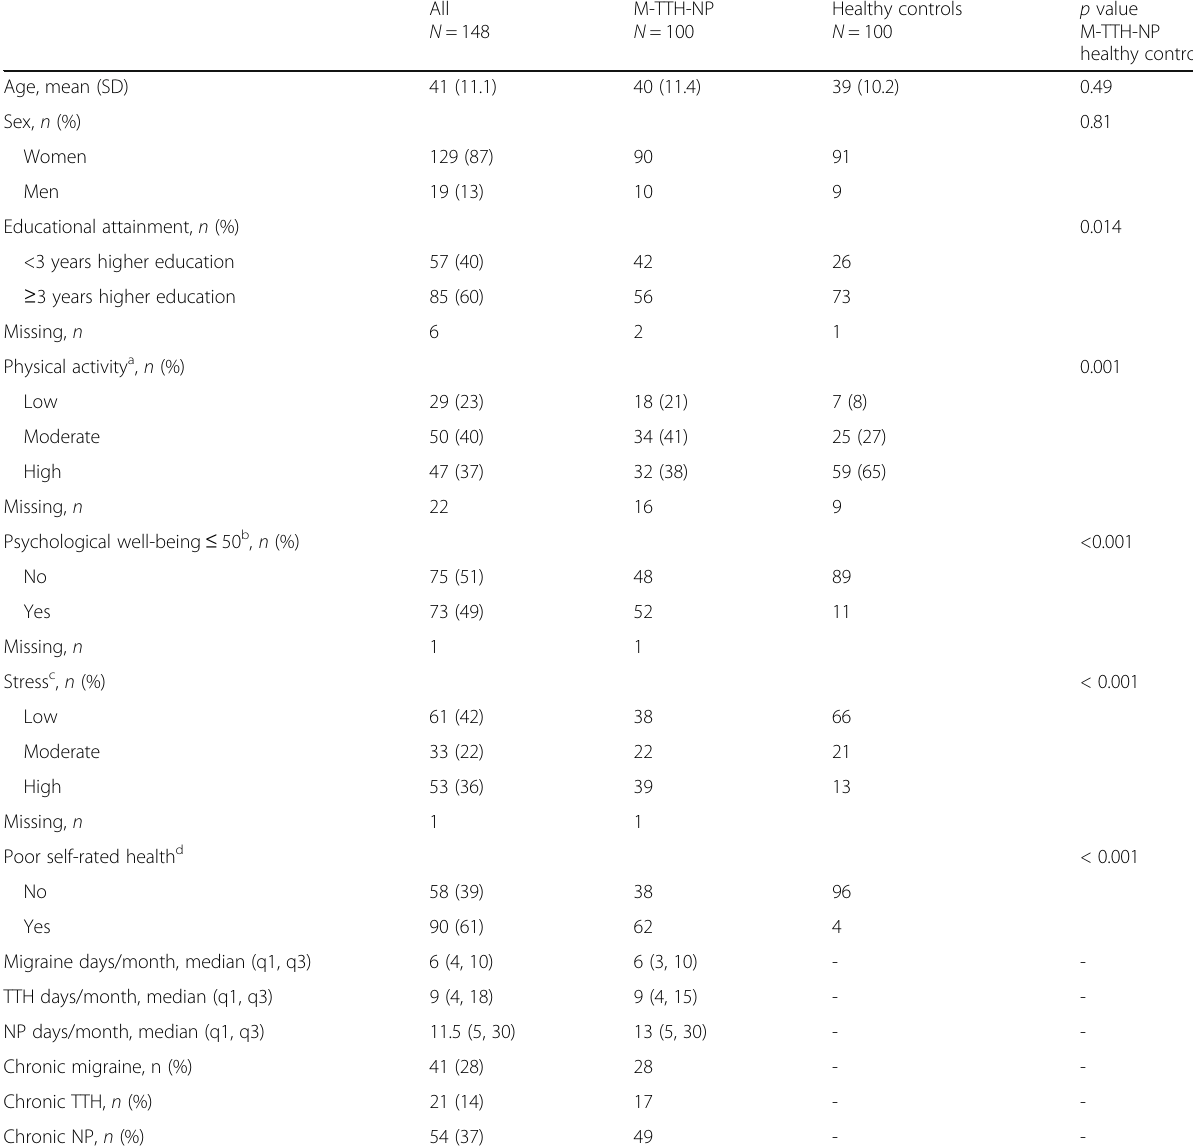
Table 1 Health-related variables, headache and neck pain frequencies in persons with co-existing M, TTH and